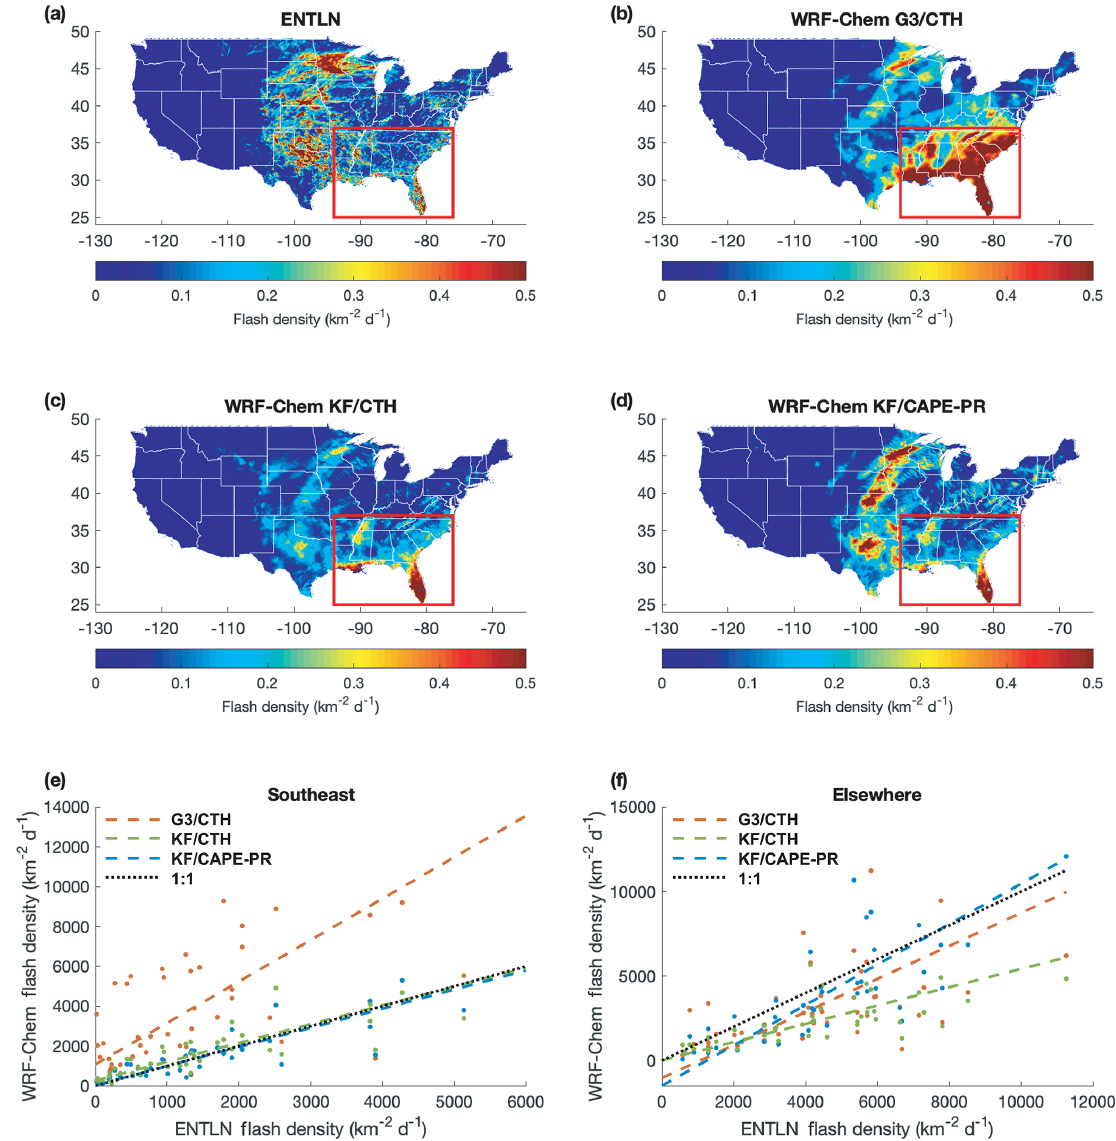
Figure 1. Observed flash densities from the ENTLN dataset (a) and WRF-Chem using three coupled convective–lightning parameterizations, the G3/CTH parameterization (b) , the KF/CTH parameterization (c) and the KF/CAPE-PR parameterization (d) . The correlation of total flash density per day between WRF-Chem outputs and ENTLN for the southeastern US (denoted by the red box in panels a–d ) is shown in panel (e) and the correlation for elsewhere in CONUS is shown in panel (f) . The model using G3/CTH is in red, KF/CTH is in green and KF/CAPE-PR is in blue. Dashed lines are corresponding fits. For slope and R 2 , see Table